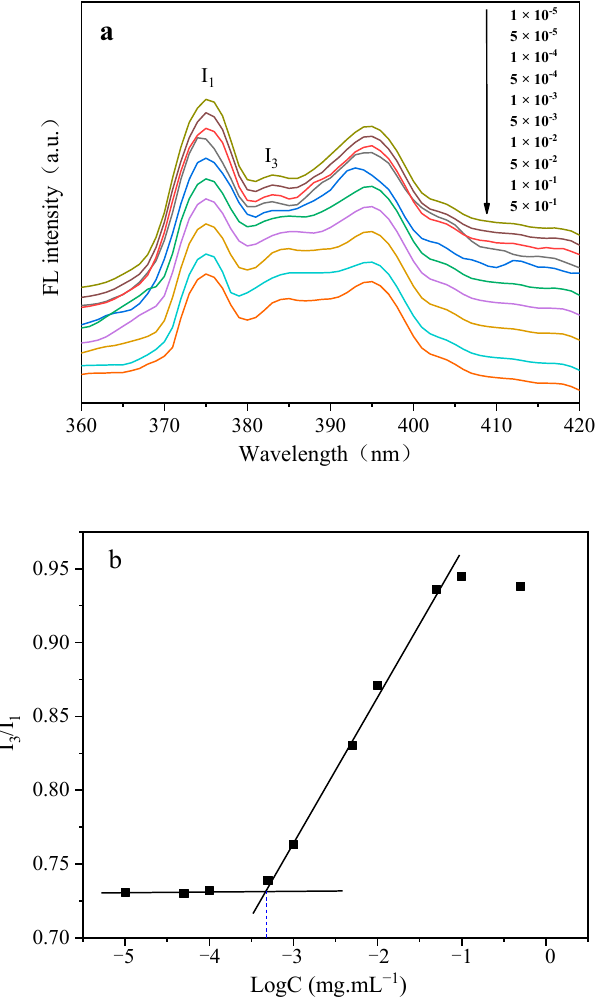
Figure 1. Emission spectra of pyrene in PMA-MPEG 1.4 solution at a fixed excitation wavelength of 334 nm at 25 °C. The concentration of pyrene was 1 × 10 − 6 M ( a ) and the intensity ratio I 3 / I 1 in the emission spectra as a function of LogC for PMA-MPEG 1.4 at 25 °C ( b ).